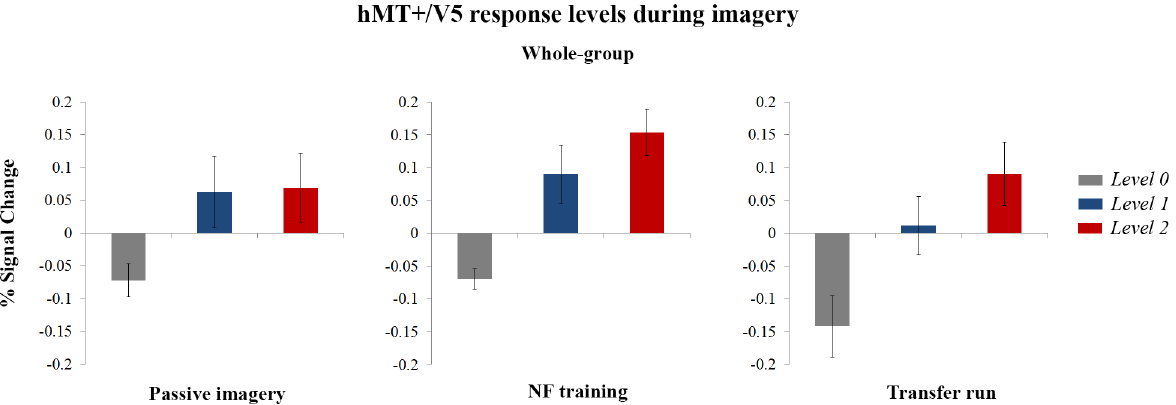
Fig 4. Mean BOLD activity within hMT+/V5 ROI during the neuromodulation runs with and without feedback. Group results ( N = 20) based on mean event-related BOLD response to the three imagery tasks in the defined ROI per participant for neuromodulation runs with feedback and for neuromodulation runs without feedback (prior passive imagery and transfer runs). Values are presented as mean ± s.e.m. Three response levels were achieved depending on the applied imagery strategy (level 0: imagery of a stationary dot; level 1: imagery of a dot with two opposing motions; level 2: imagery of a dot with four opposing motions). A significant linear trend between response levels was found during the neurofeedback ( F (1, 57) = 20.74, P < 0.0003) which persisted in the transfer run ( F (1, 57) = 11.86, P =